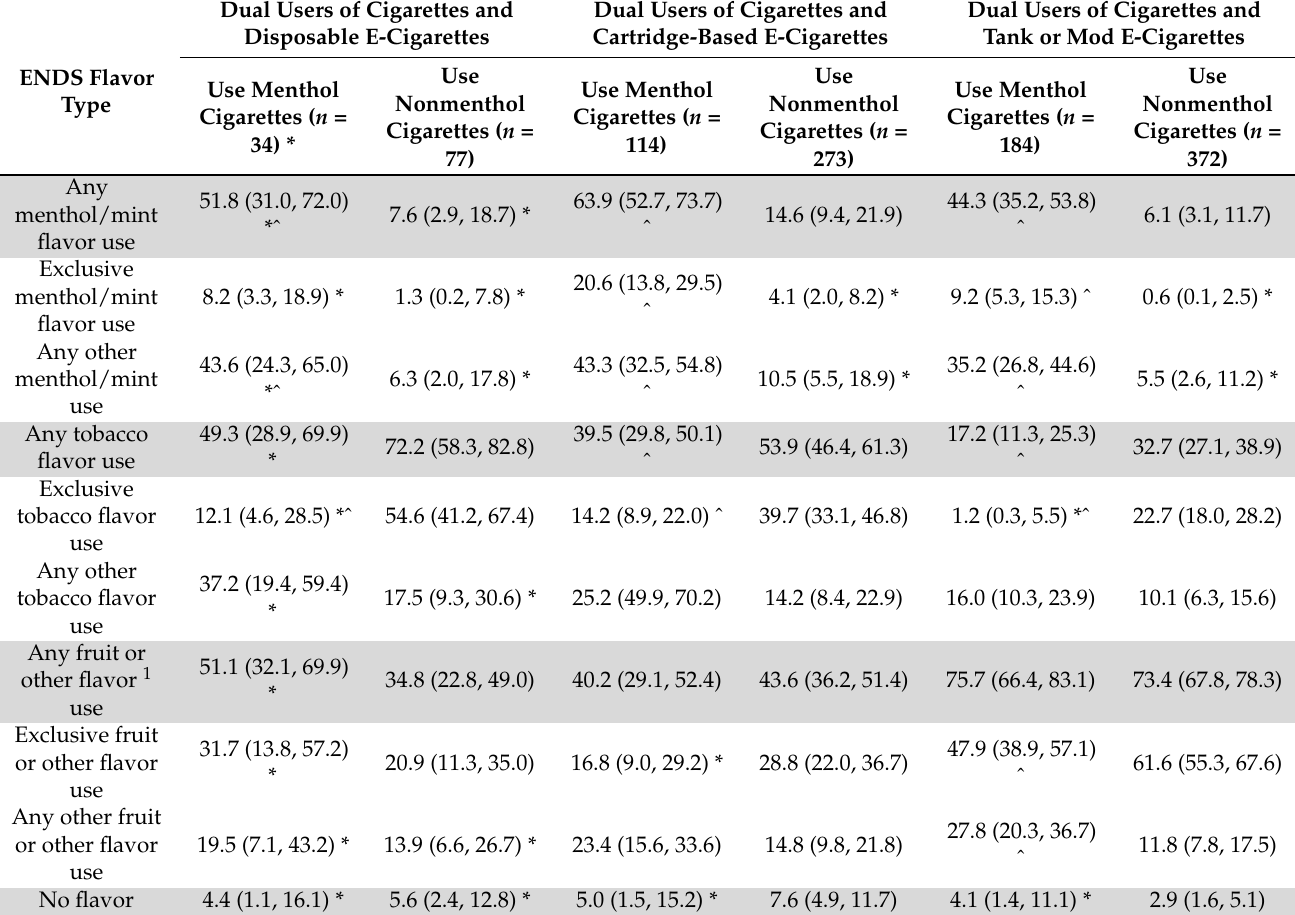
Table 2. E-Cigarette Flavor Use among Dual Users and “Switchers” by Device Type and Menthol Cigarette Smoking Status among US Adults (18+), 2018–2019 (% and 95% Confidence